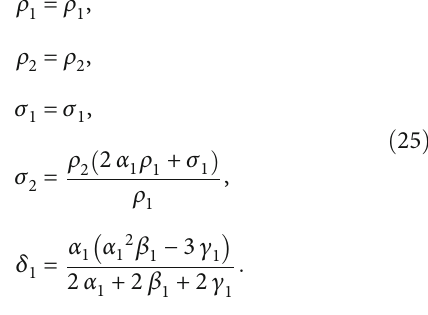
Figure 3: The three-wave solution (23) at α y = 10, and z = 2